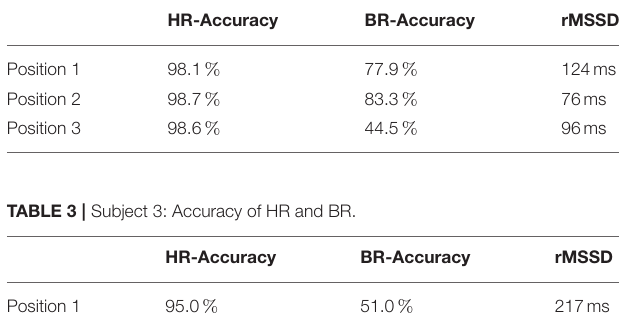
TABLE 2 | Subject 2: Accuracy of HR and BR.